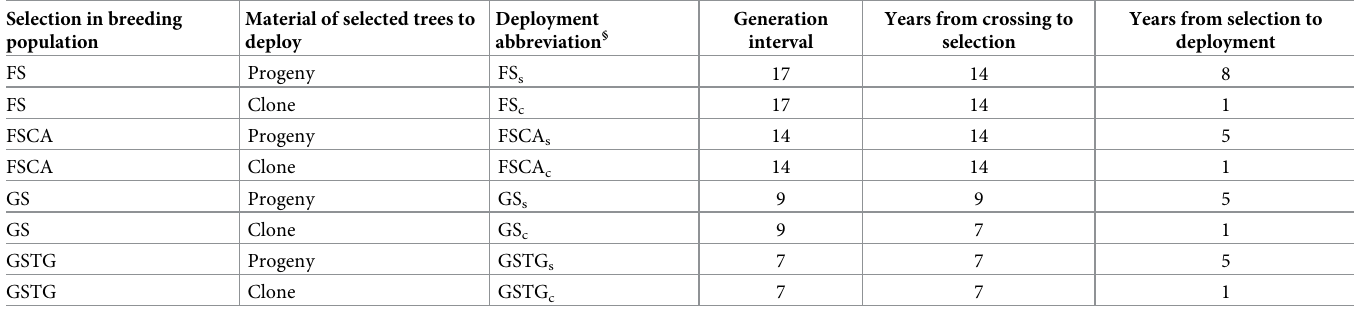
Table 1. Four selection schemes in breeding population, their combinations with two deployment options, generation interval, numbers of years needed from cross- ing parents to selection and from selection to deployment in the forest. Selection in breeding